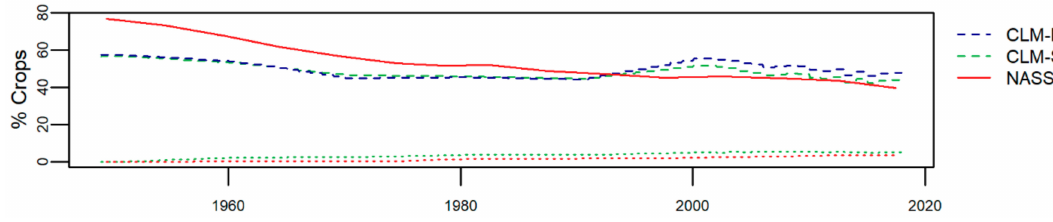
Figure 6. Comparison of crop cover and irrigation over time. Irrigated area is plotted with the same colors as non-irrigated, but with dotted lines. There is no irrigated land in